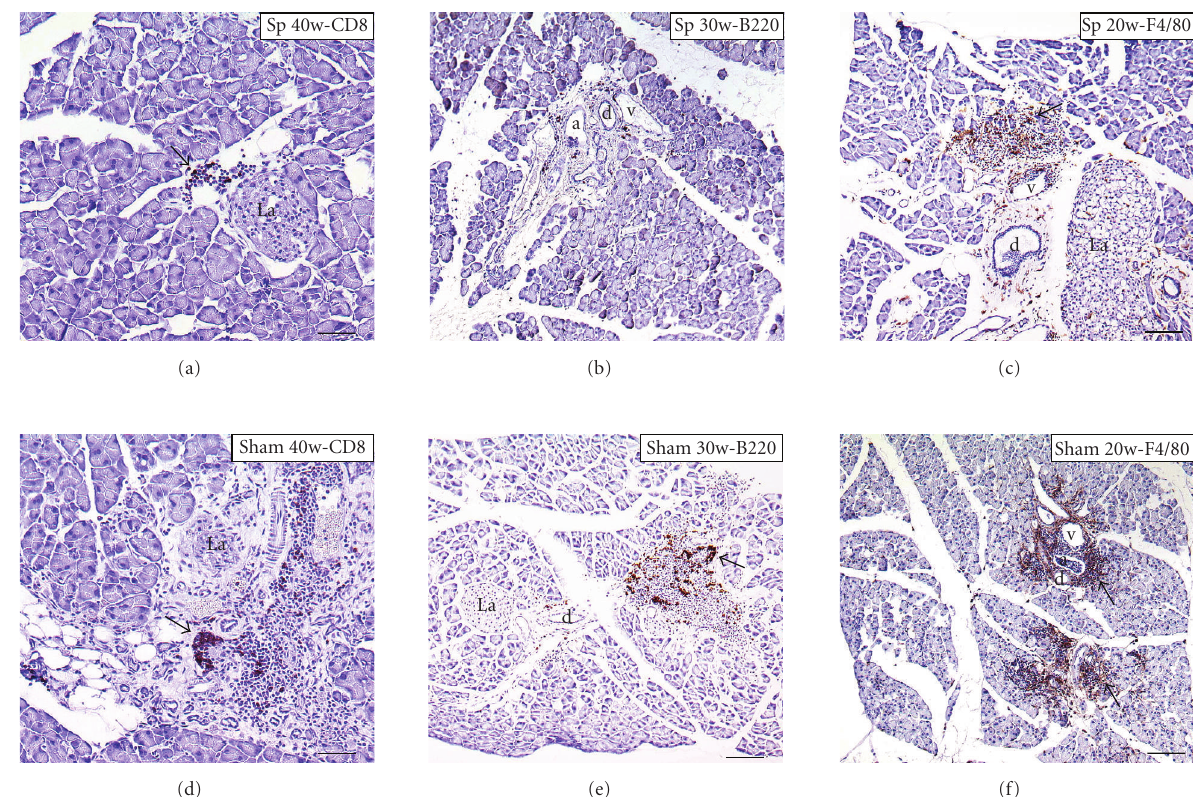
Figure 4: Immunohistopathological analysis of pancreas in splenectomized (Sp) and sham aly/aly mice by CD8a, B220, and F4/80. Arrows, indicating CD8- ((a) and (d)), B220- (e), and F4/80- ((c) and (f)) positive cells. a, artery; d, pancreatic duct; La, islet of Langerhans; v, vein. Scale bars: 100 μ m ((a), (b), and (d)); 200 μ m ((c), (e), and